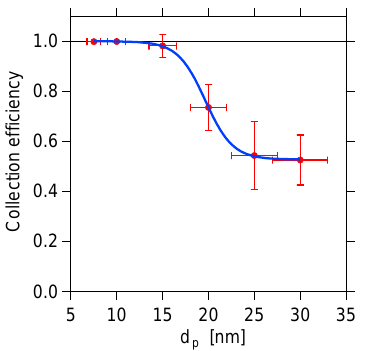
Figure 6. Collection efficiency depending on the particle size. Due to the decreased electrical mobility, the required collection voltage increases with particle size, which currently limits the collection efficiency at larger